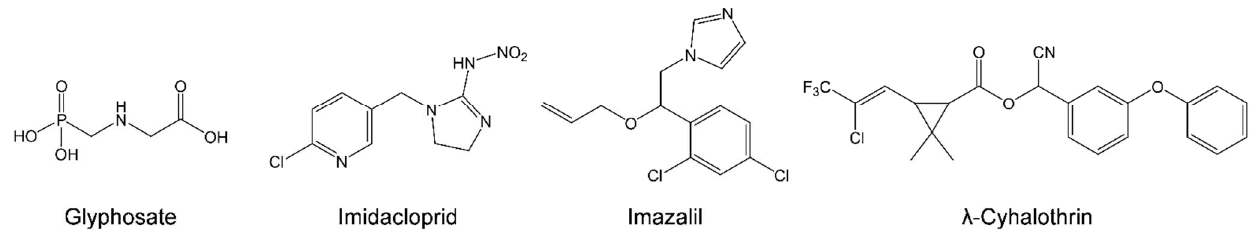
Figure 1. Chemical structure of the herbicide glyphosate, the fungicide imazalil and the insecticides imidacloprid and λ-cyhalothrin.